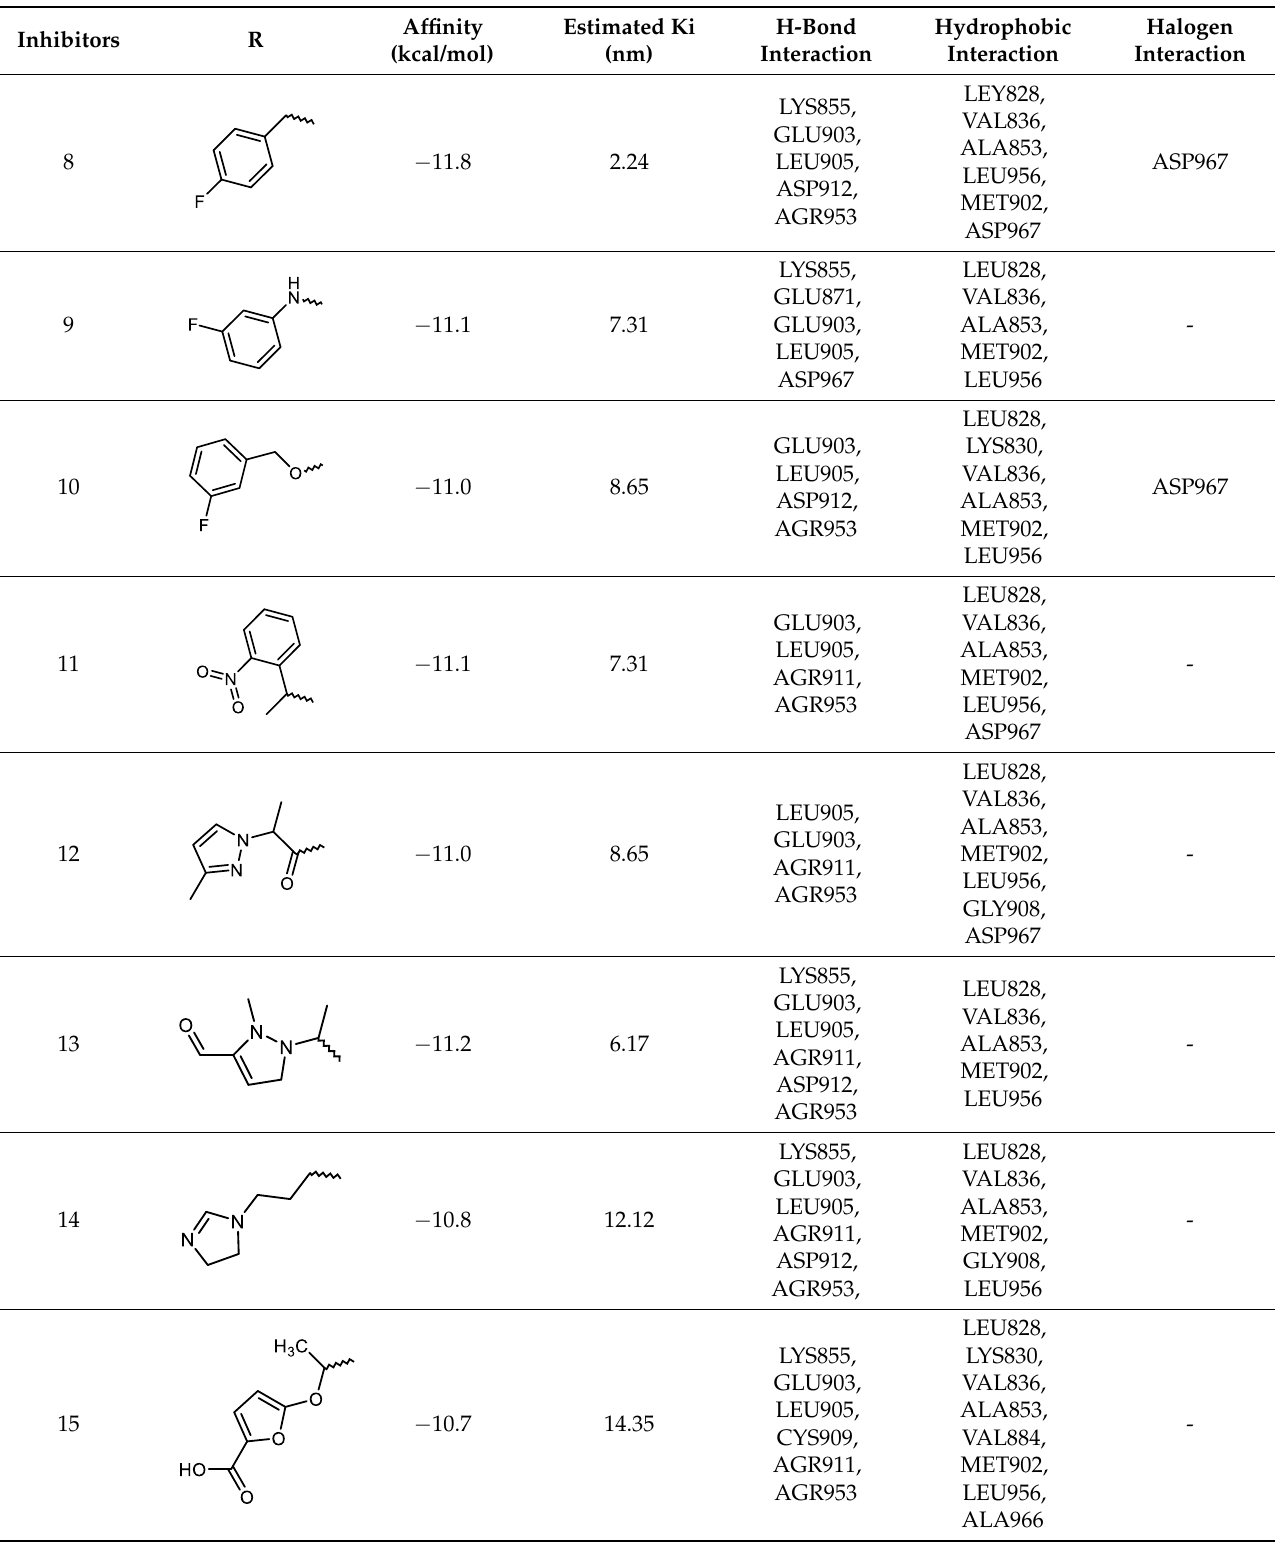
Table 1. Structures of the top 14 inhibitor R-groups and the docking scoring and binding mode of the inhibitor to the receptor (PDB ID:5LWN).